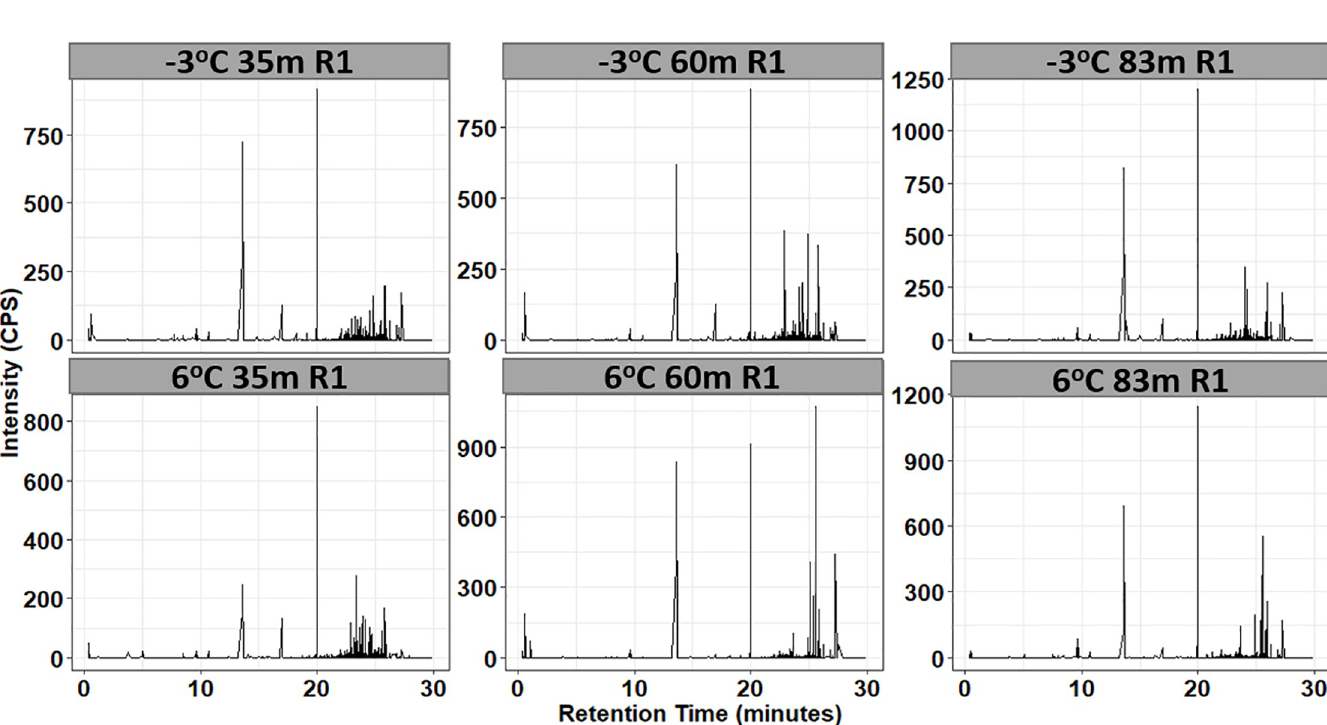
Fig 2. Representation UPLC chromatograms of metabolites from microbial cells in permafrost soil sample collected at the location 35m into the North Tunnel and incubated at -3˚C and 6˚C in ESI+ mode. R1 denotes the repetition 1 and intensity is measured in counts per second (CPS).